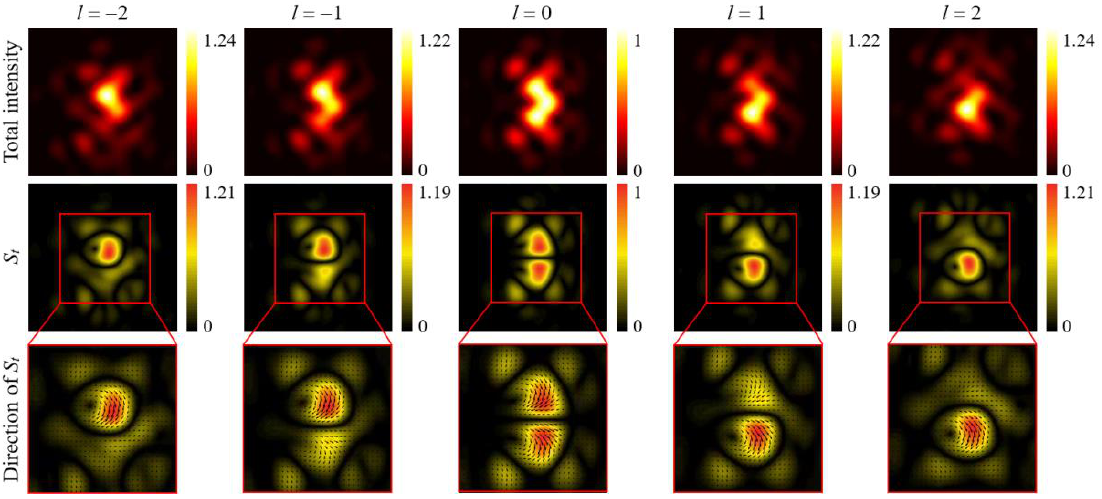
Figure 6. The total intensity and transverse SAM density of the tightly focused SM-HP-VOF with segmented vortex phase modulation when ( N , m ) = (4, 1) . The topological charges of the vortex phases are l = − 2 , − 1, 0, 1 and 2 in five columns, respectively. The focal intensity, transverse SAM density S t and the direction of S t are given in the three rows, respectively. The numerical aperture of the focal lens is NA = 0.95 , and any picture in the first two rows has a size of 4 λ × 4 λ , and any picture in the third row has a size of 2.5 λ × 2.5 λ .